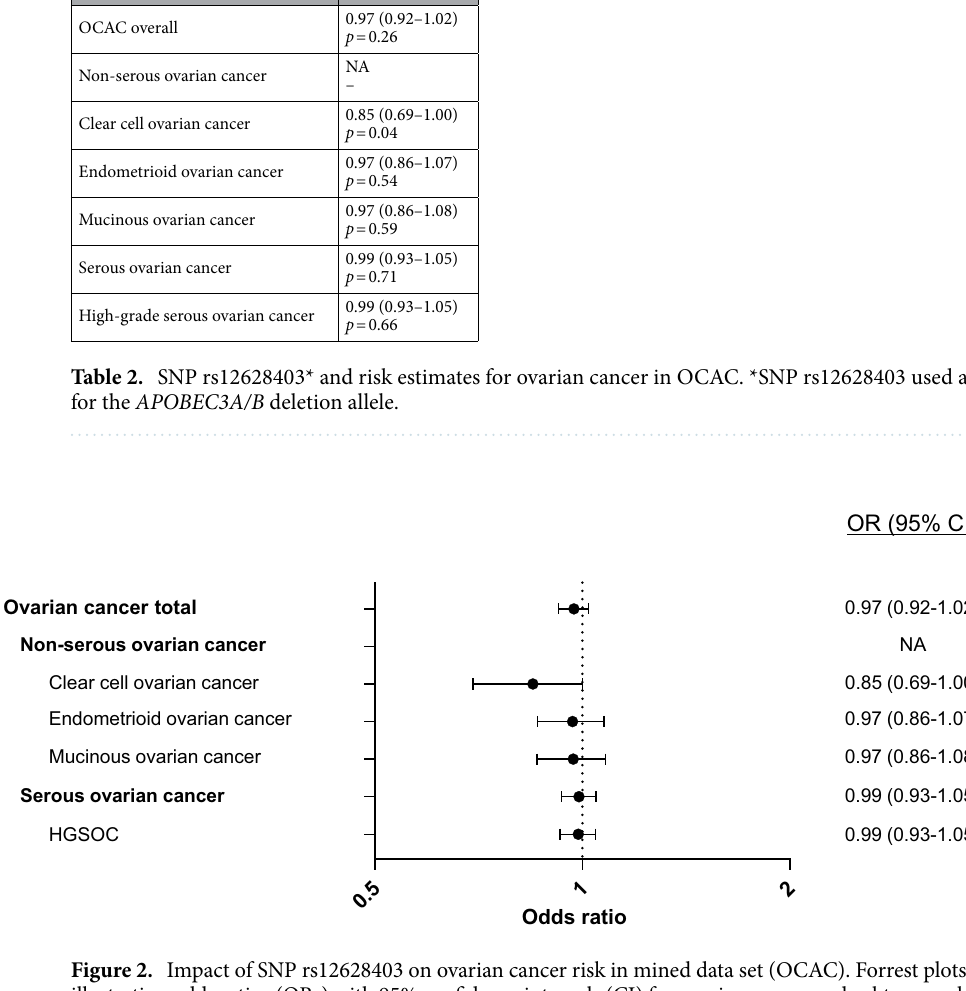
Figure 2. Impact of SNP rs12628403 on ovarian cancer risk in mined data set (OCAC). Forrest plots illustrating odds ratios (ORs) with 95% confidence intervals (CI) for ovarian cancer and subtypes, related to SNP rs12628403. Available data (allele model) mined from the Ovarian Cancer Association Consortium (OCAC) online data